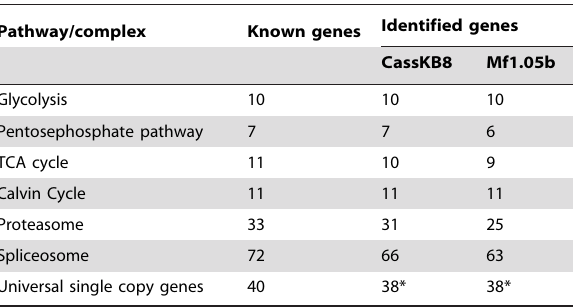
Table 2. Annotation of pathways and complexes in the transcriptome data (values are numbers of genes, i.e. contigs and singlets clustered at 90% similarity).